Question: From the figure, is the trend upward or downward?
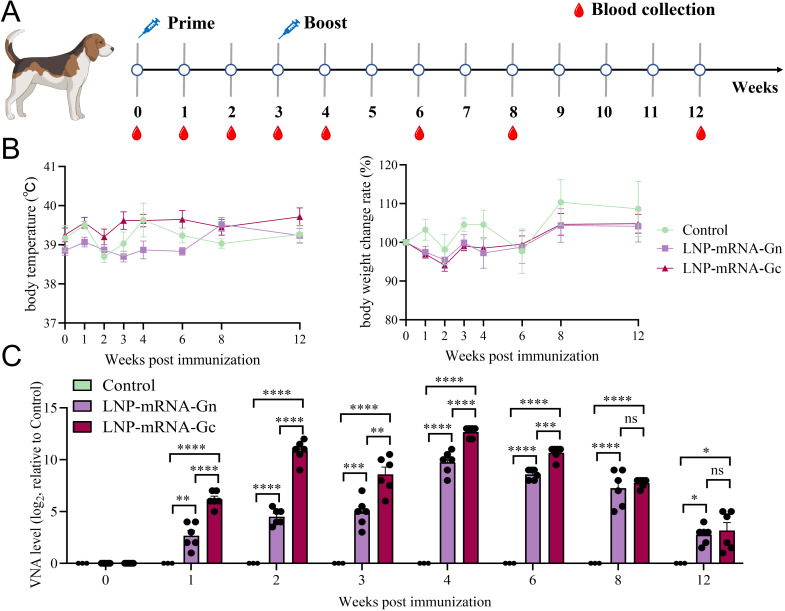
Answer: increasing